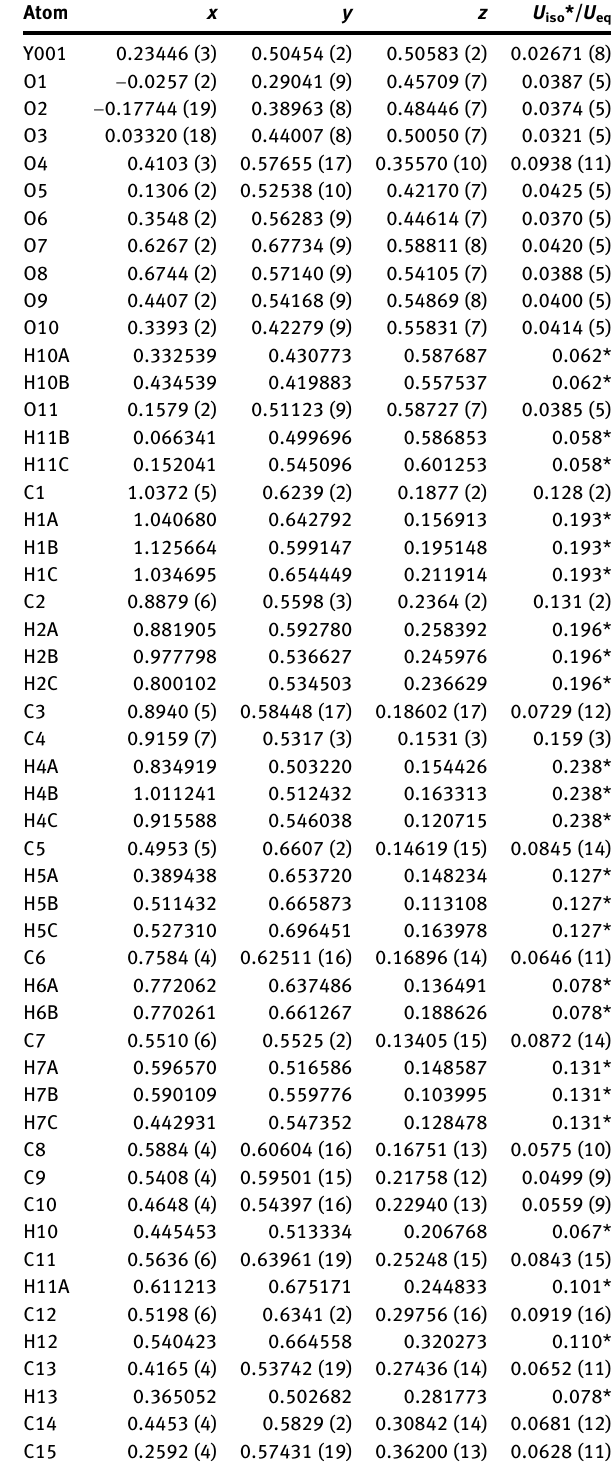
Table  : Fractional atomic coordinates and isotropic or equivalent isotropic displacement parameters (Å 